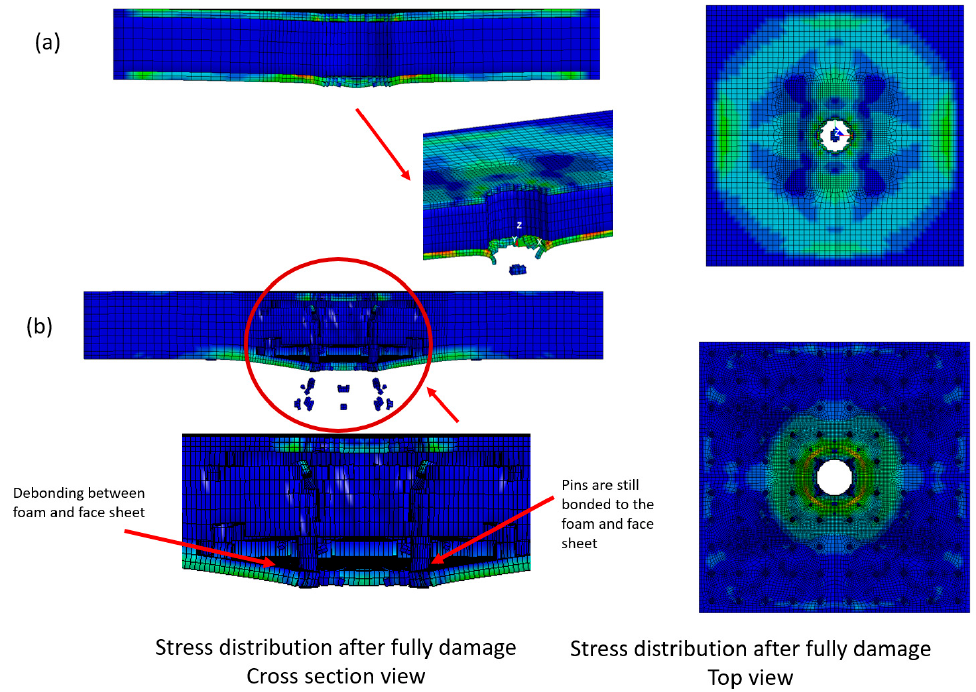
Figure 12. Stress distribution and failure observation of ( a ) FCS, ( b ) 3 mm PFCS panels subjected to 500 mm/min.